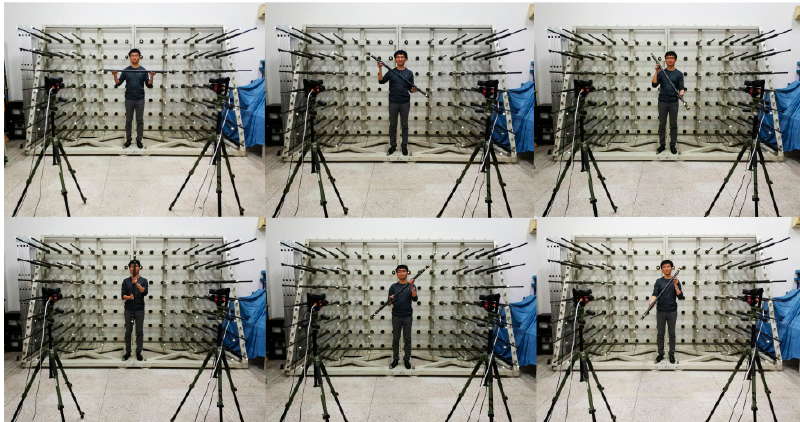
Figure 14. Rotating the bar in one position.